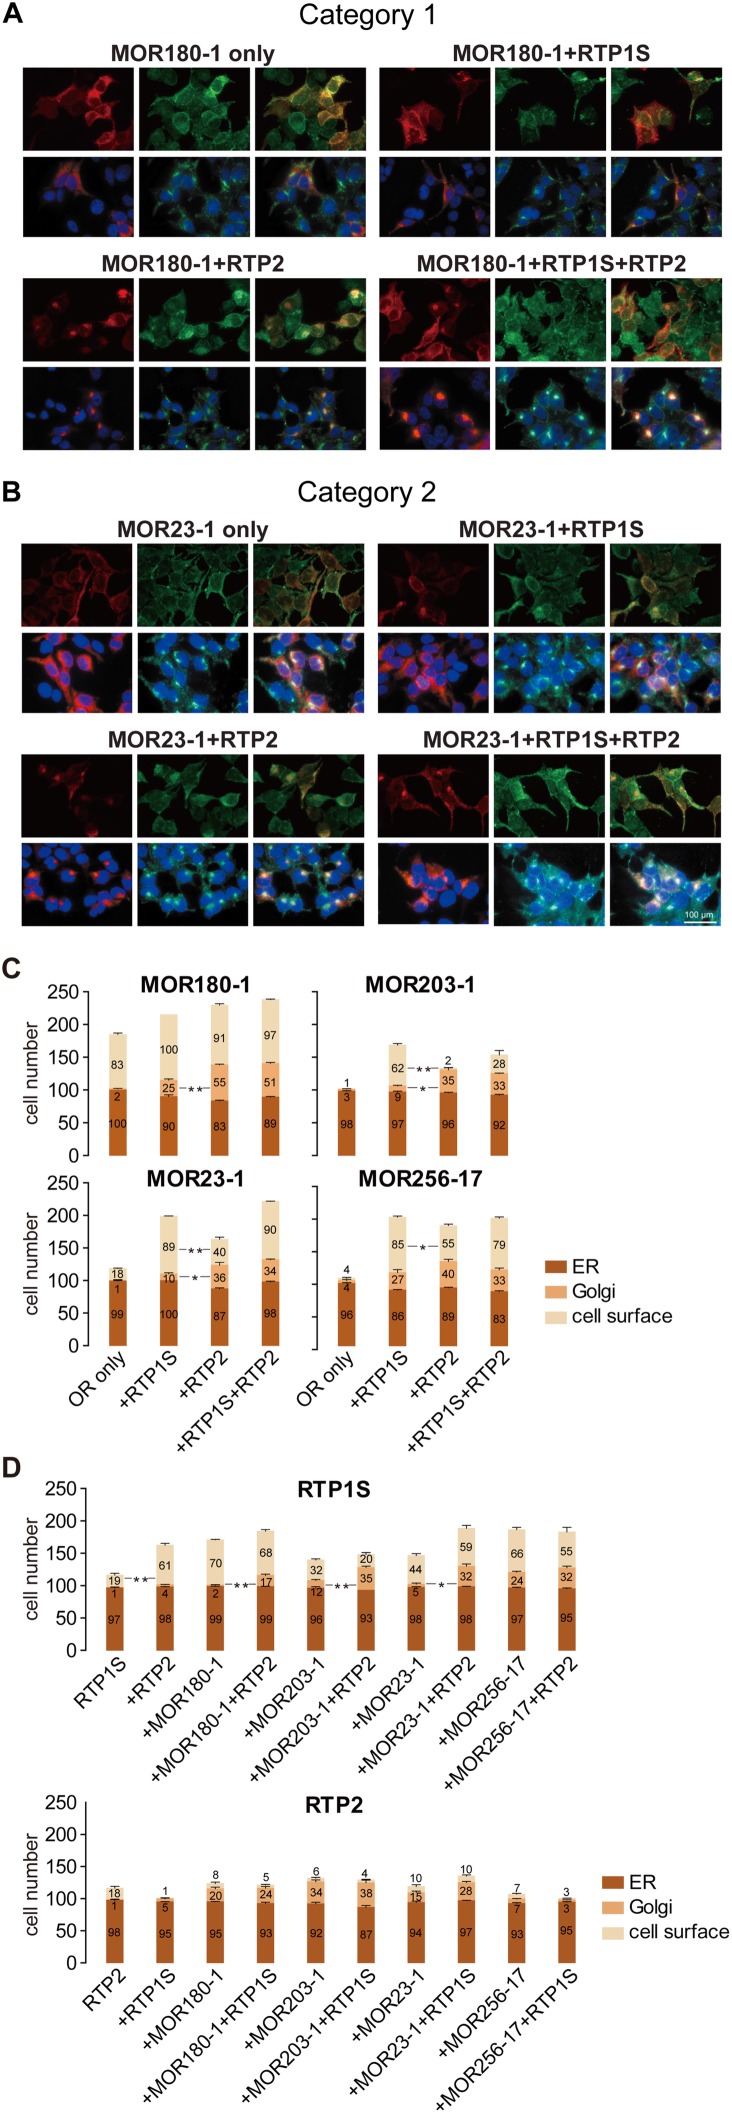
RTP1S and RTP2 play divergent roles in OR trafficking.(A-B) permeabilized staining were performed to examine the subcellular localizations of MOR180-1 (Category 1) and MOR23-1 (Category 2) when they were transfected alone or cotransfected with different RTPs or a combination of the two RTPs. Left panels, red signals represent the localization of OR proteins. Middle panel, green signals represent staining of organelles; first row, staining of ER with calnexin; second row, staining of Golgi with wheat germ agglutinin. Right panels, yellow signals represent OR proteins merged with the corresponding organelle. Blue signals in the second row are DAPI nuclear staining. Scale bar, 100 μm. (C-D) quantification of the cell-surface expression and subcellular localizations of the 4 tested ORs and RTPs. Columns represent the cells of each counting session where the OR or RTP proteins were localized in the ER, the Golgi, or at the cell surface. The y-axis represents the cell numbers of each counting session where the OR or RTP proteins were localized in ER, Golgi, or at the cell surface, shown as mean ± S.E.M. (N = 3). Paired two-tailed t test was used to compare the localizations in certain organelle or at the cell surface when different combinations of OR and RTP were cotransfected. * P < 0.05, ** P < 0.01.